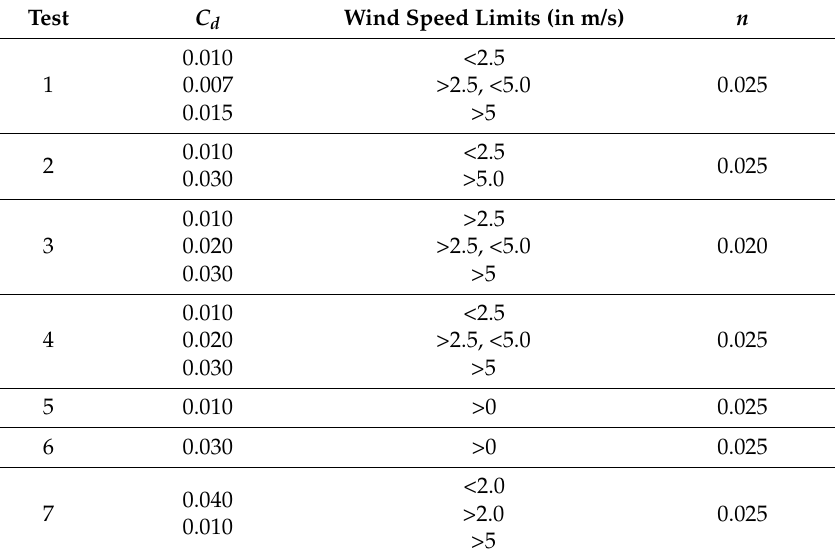
Table 2. Wind drag and Manning coefficients tested during calibration.